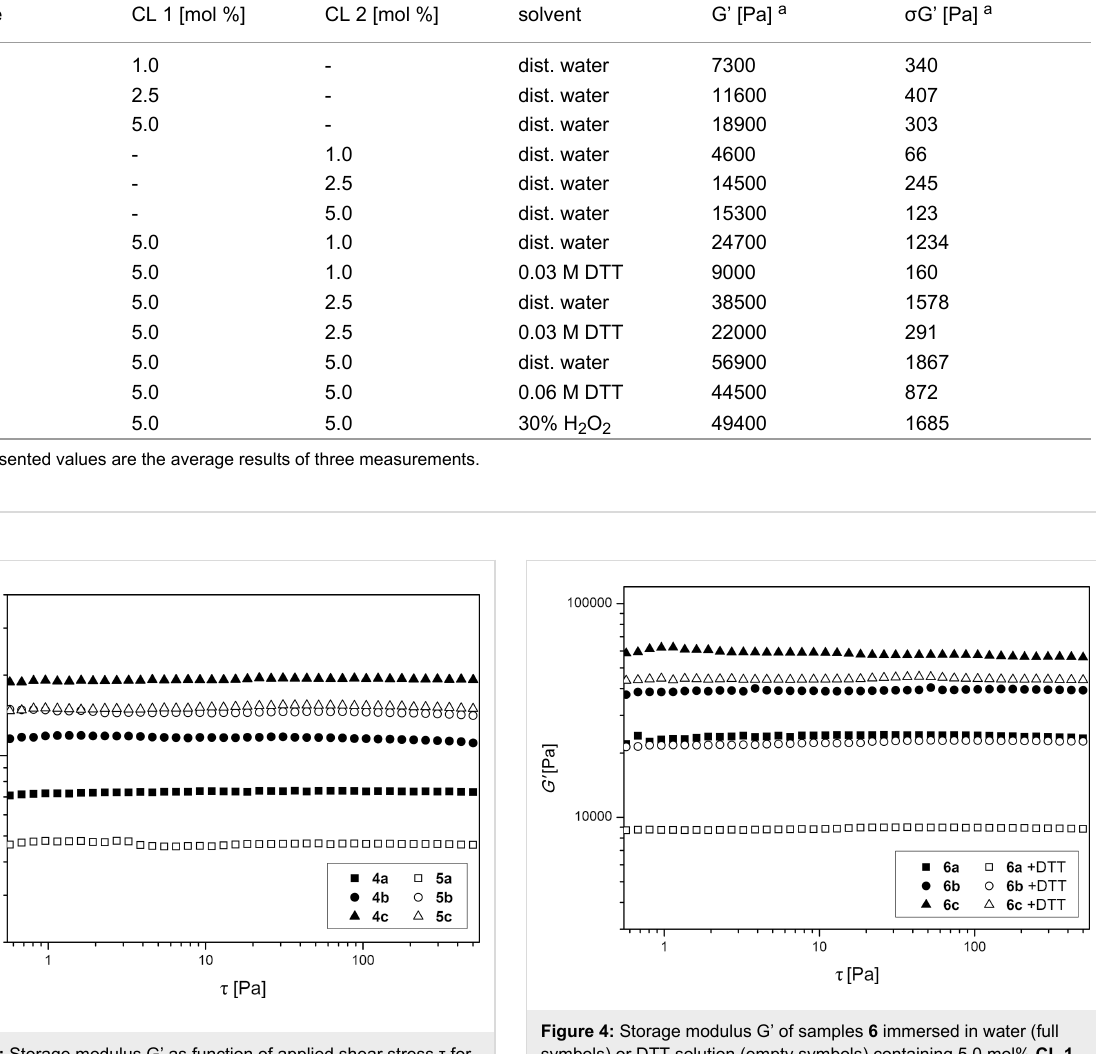
Table 2: Results for oscillatory measurements of polymer discs containing CL 1 and / or CL 2 after immersion in different solvents. sample